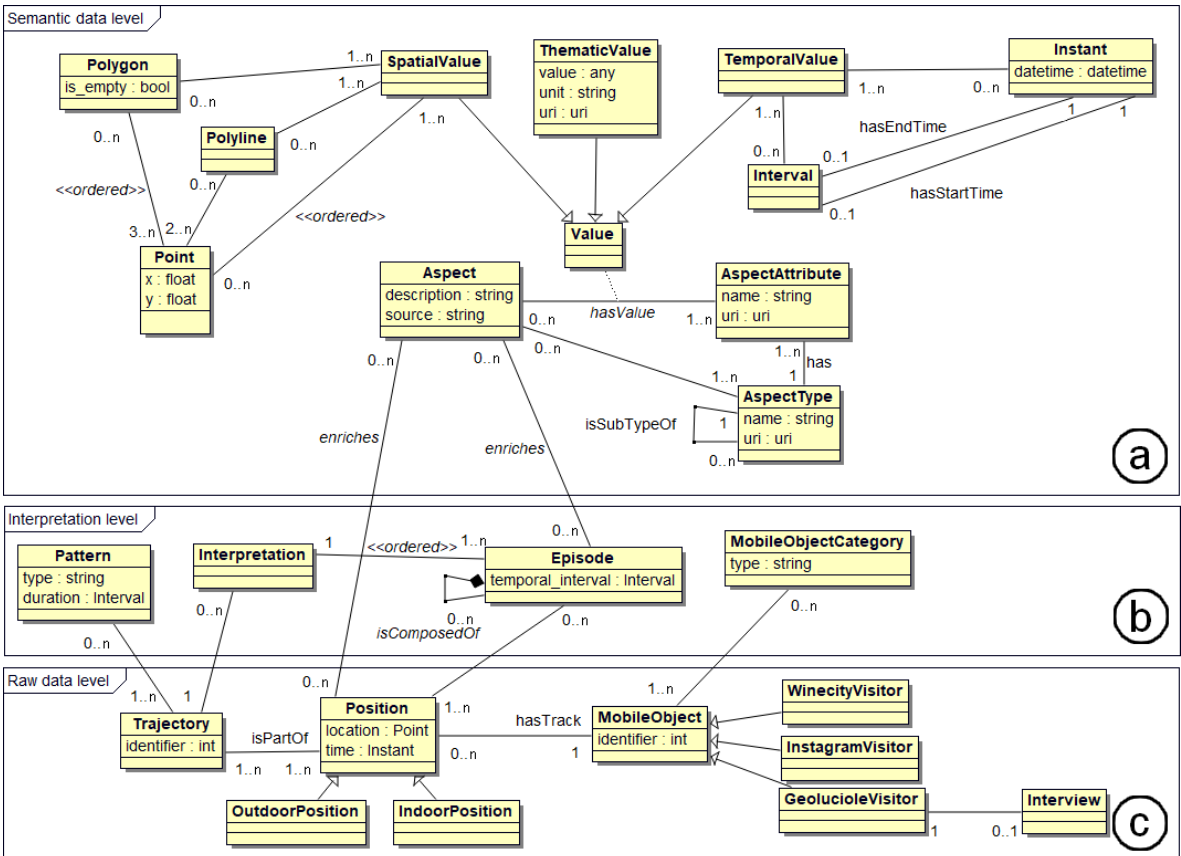
Figure 2. Semantic trajectory model: ( a ) semantic data level, ( b ) interpretation level, ( c ) raw data